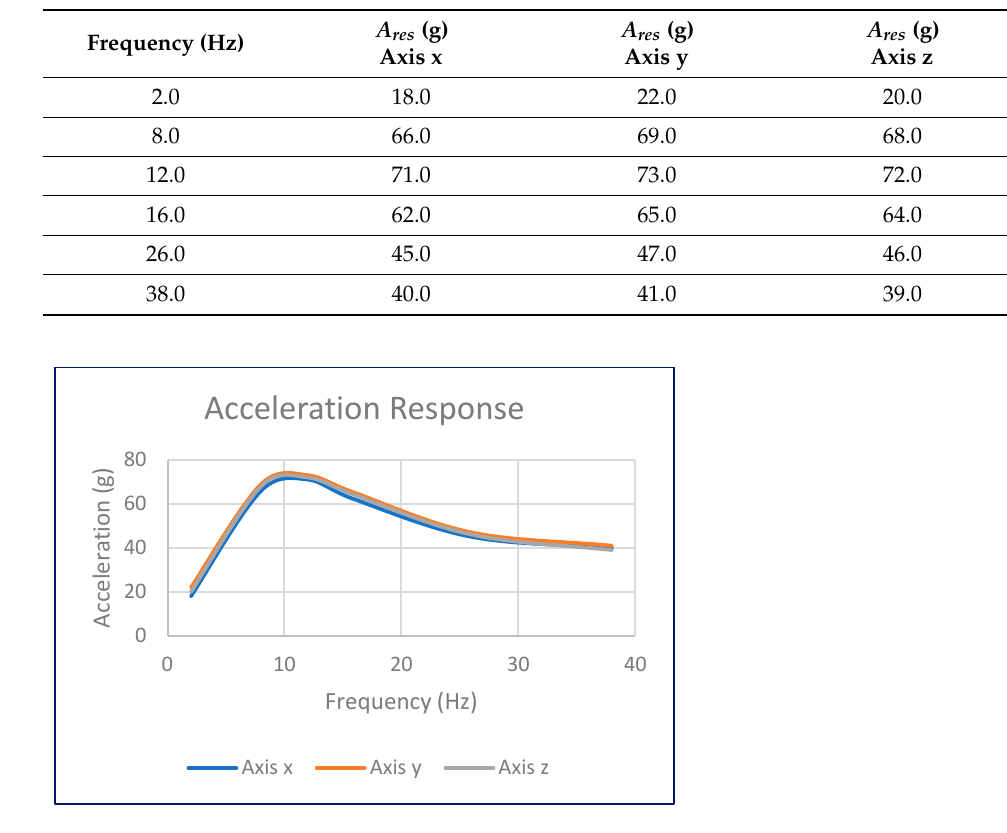
Figure 5. Acceleration response (three axes). Table 3. Vibration stress